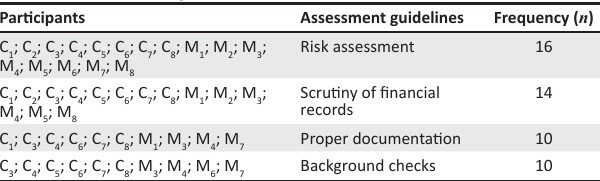
TABLE 2: Participants’ perspectives on assessment guidelines used by the formal financial institutions to grant credit. Participants Assessment